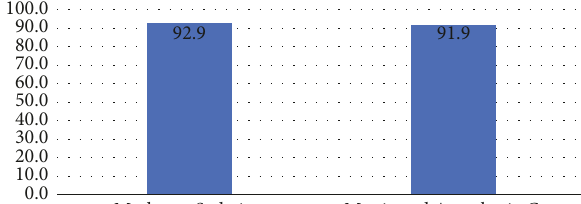
and 87.9% (p=0.693) and NPV of 80.6% and 80.5% (p=0.994) for MS and MAC, respectively (Figure